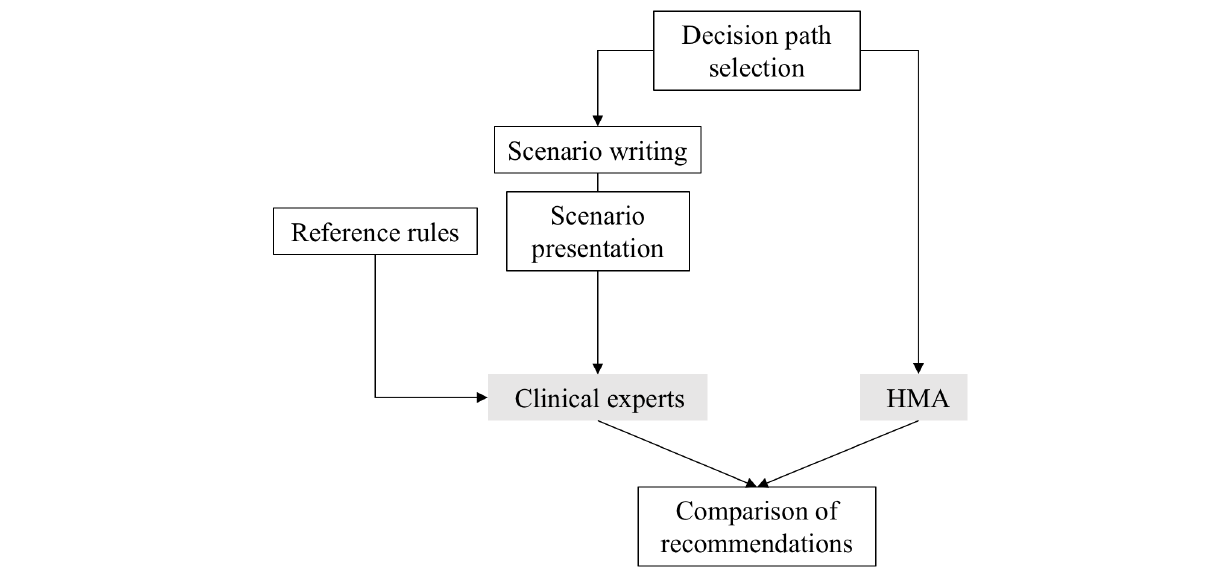
Figure 2. Process used to evaluate the accuracy of the knowledge